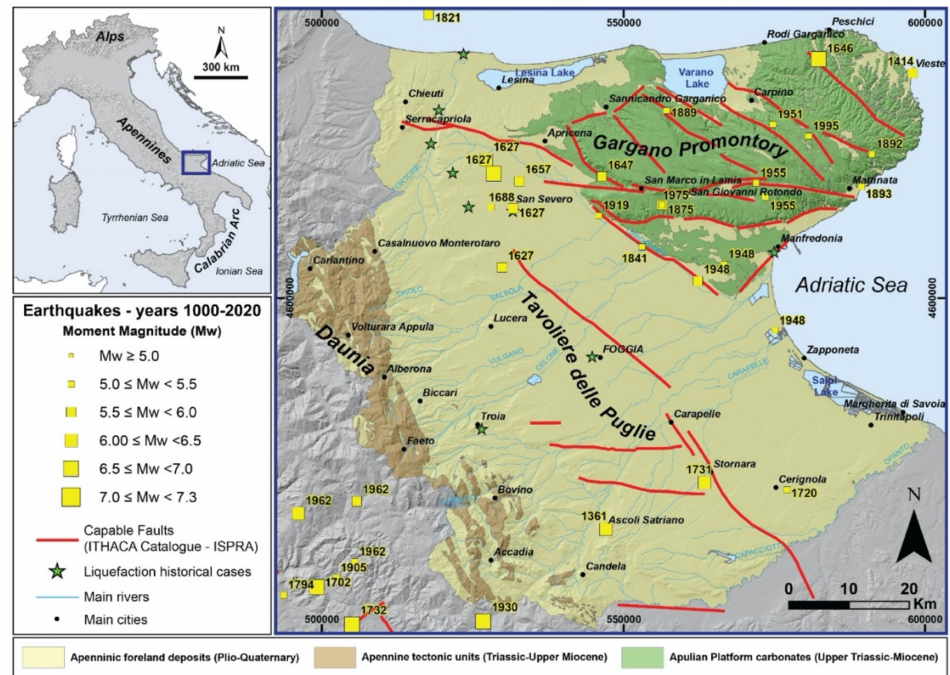
Figure 1. Simplified structural and lithological map of the study area; location in southern Italy indicated in inset by blue square. The capable faults are from ITHACA Catalogue (ITaly HAzards from CApable faulting [44]) and major (Mw ≥ 5.0) historical and instrumental earthquakes are from Rovida [42,43]). Green stars show the main cases of soil liquefaction induced by historical earthquakes (from